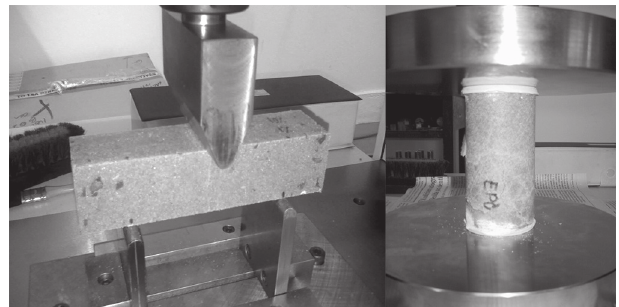
Figure 2. Flexural and compressive test